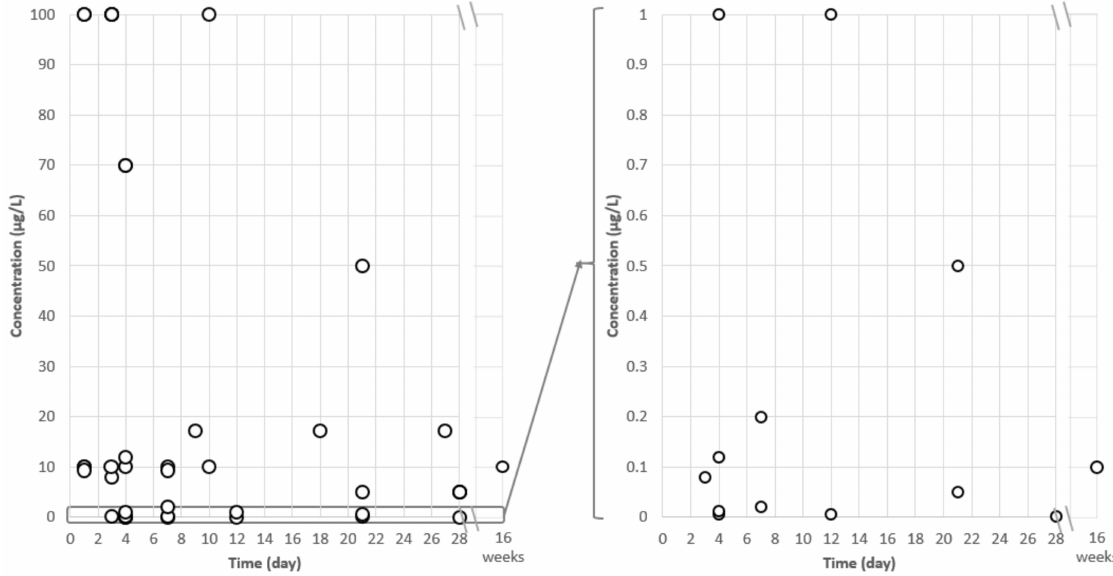
Figure 1. Relationship between PhAC exposure time (days) and concentration ( µ g/L) based on the findings of 44 experiments performed in the 16 studies selected in this